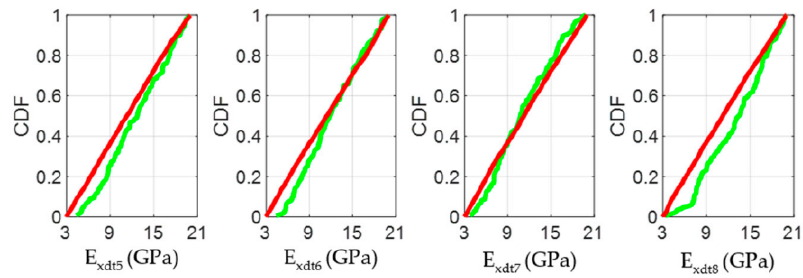
Figure 19. Cumulative Distributions Functions (CDFs) of the four input factors located in the central third of the timber board # 28 ( E xdt in zones 5 to 8) for the output metric (Y function). The green and red curves represent the sets B (behavioral) and NB (non-behavioral), respectively.